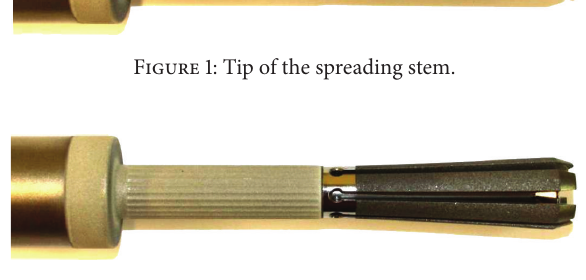
Figure 2: Tip of the spreading stem with open fins.